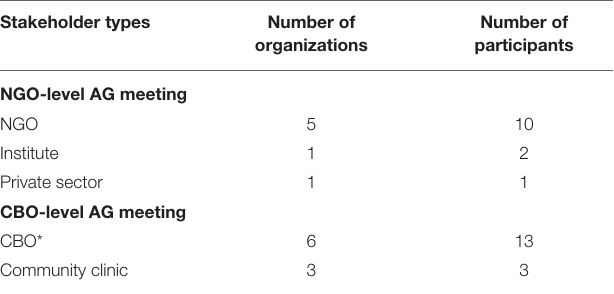
TABLE 1 | Participant-types in AG stakeholder mapping